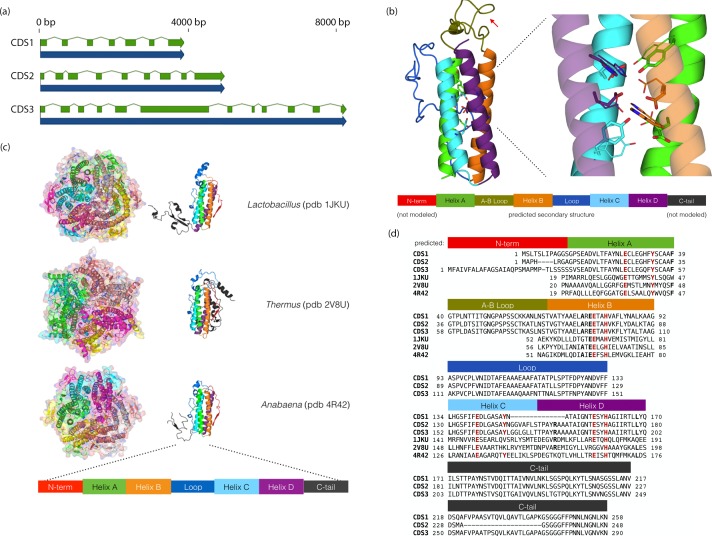
Chloroidium sp. UTEX 3007 genes exhibiting homology with desiccation-responsive Deinococcus genes.(a) Gene models for the putative manganese catalases (CDS1/2/3). Functional annotation of homologs from (CDS1/2/3) is limited: 96 of the top 100 BLAST hits of CDS3 in the non-redundant database (nr v. 2.31, NCBI) are annotated as hypothetical or predicted proteins. Of the other four, three are characterized as desiccation related (from Auxenochlorella protothecoides, Deinococcus gobiensis I-0, and Salinisphaera shabanensis E1L3A). (b) Experimental structures of representative Mn catalases (Antonyuk et al., 2000; Barynin et al., 2001; Bihani et al., 2013) showing the homohexamers (left) and isolated monomers (right). The latter are colored according to structural motifs as given. (c) Left: Homology model of CDS3, colored according to linear structure shown below (the additional presumptive loop is indicated by the red arrow and the predicted Mn coordinating side chains are shown as sticks). Right: Zoom in of same homology model aligned with the metal coordinating residues of Anabaena PCC 7120 Mn catalase (pdb 4R42); highlighting the spatial alignment of side chains (homology model side chains shown as thick sticks, 4R42 as thin sticks). (d) Sequence alignment of CDS1-3 shown with the predicted secondary structure. The presumptive helical regions are also aligned with the corresponding sequences from the known Mn catalase structures. Canonical Mn coordinating residues are in red and other positions with sequence identity between CDS1-3 and at two least of the known catalases are in bold.DOI:
http://dx.doi.org/10.7554/eLife.25783.02410.7554/eLife.25783.025Figure 7—source data 1.Models of CDS1-3 in protein data bank (PDB) format.DOI:
http://dx.doi.org/10.7554/eLife.25783.02510.7554/eLife.25783.026Figure 7—source data 2.Amino acid residue alignment of CDS1-3.